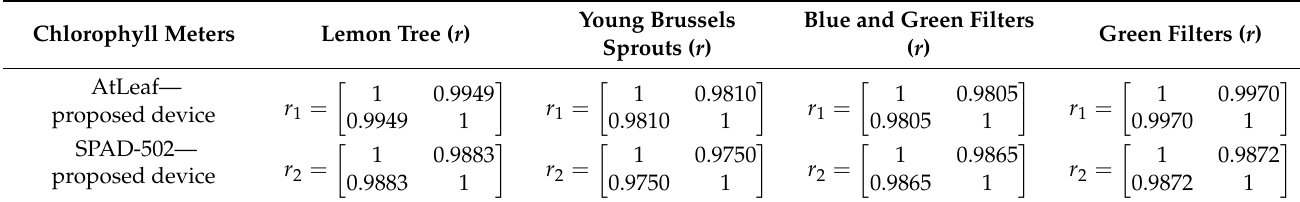
Table 2. Correlation coefficient matrices between commercial devices and our proposed